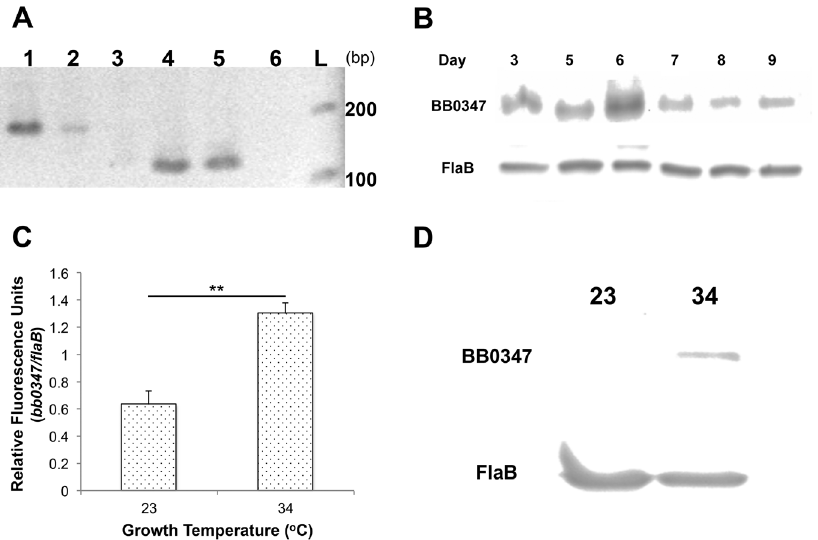
Figure 1. BB0347 is expressed and produced in culture. A) Expression of BB0347 was verified by RT- PCR with flaB mRNA as a control. Lane 1: flaB from genomic DNA, lane 2: flaB from cDNA, lane 3: no RT control, lane 4: bb0347 from genomic DNA, lane 5: bb0347 from cDNA, lane 6: no RT control, L: ladder. B) Western blotting shows that BB0347 protein is produced in the spirochete at all sampled time points. C) QRT- PCR of bb0347 at two different temperatures of incubation with flaB as a standard. D) Western blot using a BB0347 and a FlaB against whole-cell lysates from spirochetes grown at either 34 or 23 u C to similar cellular densities. All figures are representative of at least two independent experiments with similar results, and error bars indicate 6